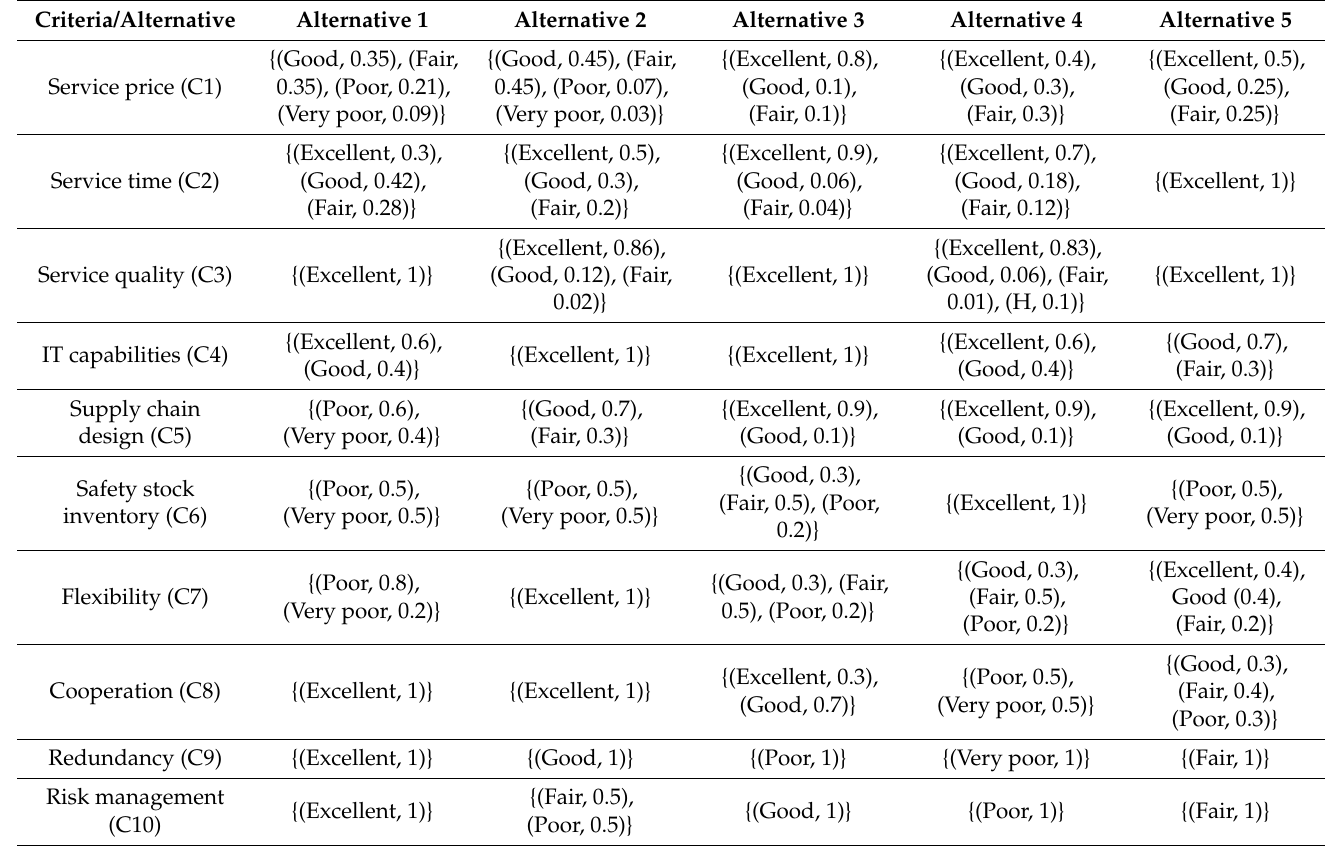
Table 11. Transformed assessment